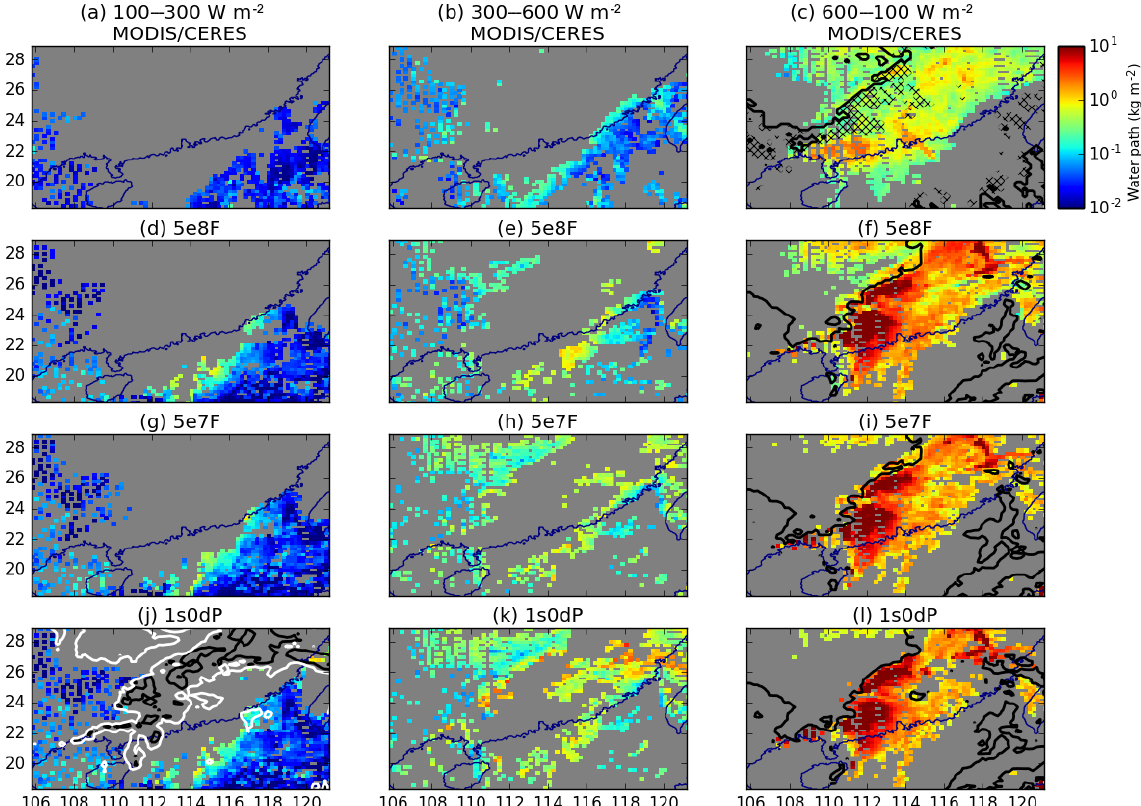
Figure 7. Total condensed-water path (all species of hydrometeor) in the MODIS observations (a–c) , 5e8F (d–f) , 5e7F (g–i) and 1s0dP (j–l) . The fields are partitioned into three SW-flux intervals: fluxes between 100 and 300Wm − 2 (a, d, g, j) , fluxes between 300 and 600Wm − 2 (b, d, h, k) and fluxes greater than 600Wm 2 (c, f, i, l) . For each panel, points outside the corresponding interval of fluxes have been masked out in grey. The black contour in (c, f, i, l) encloses the regions where the fraction (by mass) of the total condensed-water path that is ice exceeds 20%. In panel (j) the contours show where the column integrated aerosol in the lowest 5km of the atmosphere are 20 percent (black) and 80 percent (white) of the domain-mean aerosol